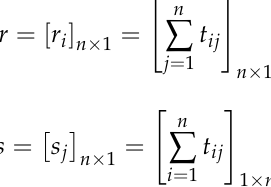
Procedure 4: Building the normalized total criteria relationship matrix. Through Equation